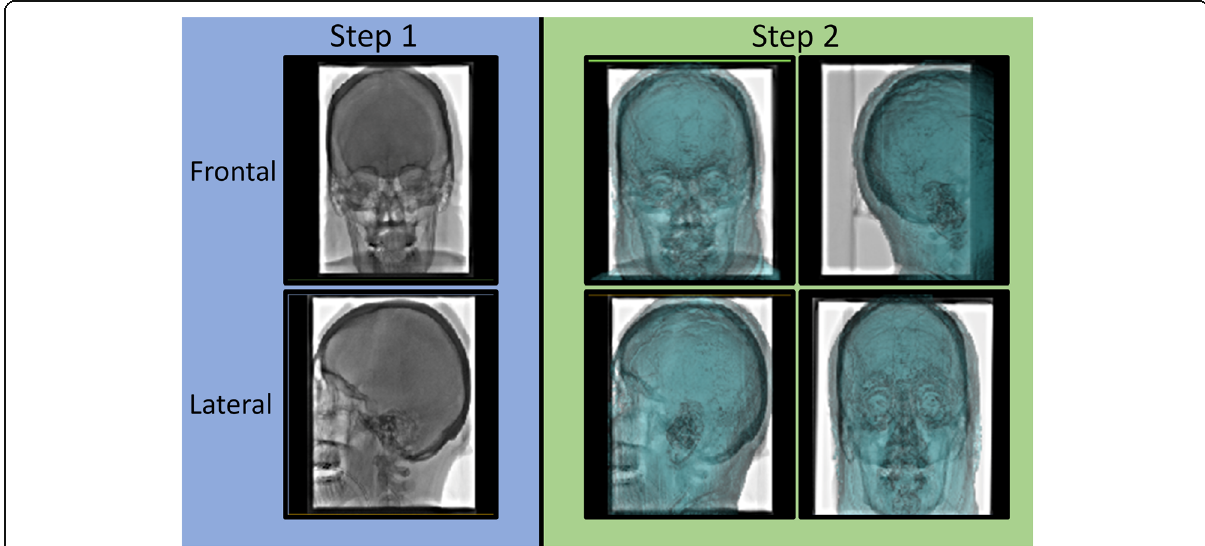
Fig. 2 MRV Model Registration Procedure. Step 1 is performed in the angiosuite and requires the operator to acquire two fluoroscopic images at different obliquities in both the frontal and lateral planes. Step 2 is performed in the control room and allows the user to register the acquired images with the 3D MRV skull model in both the frontal and lateral